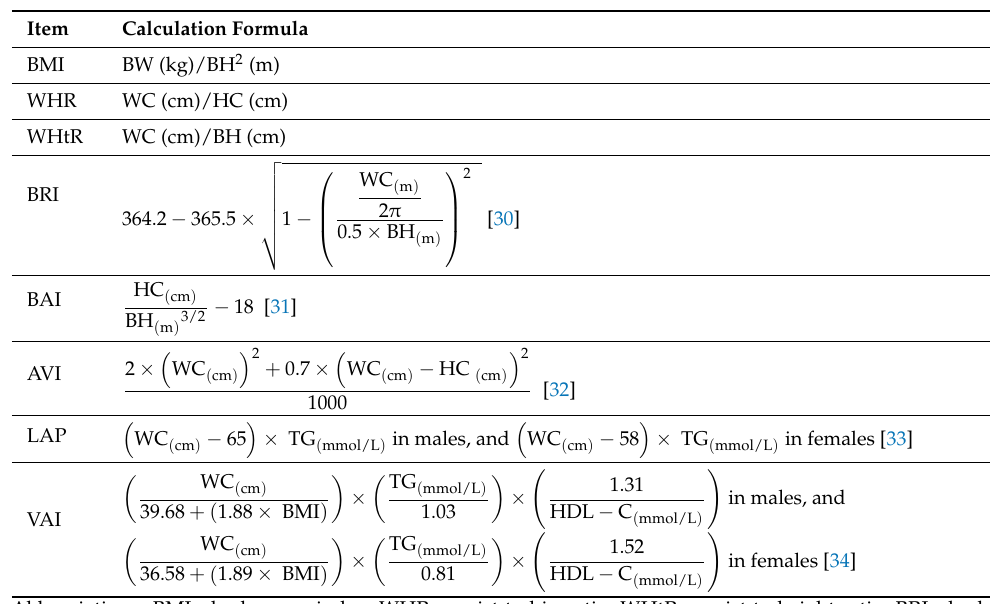
Table 1. Calculation formula of each obesity-related